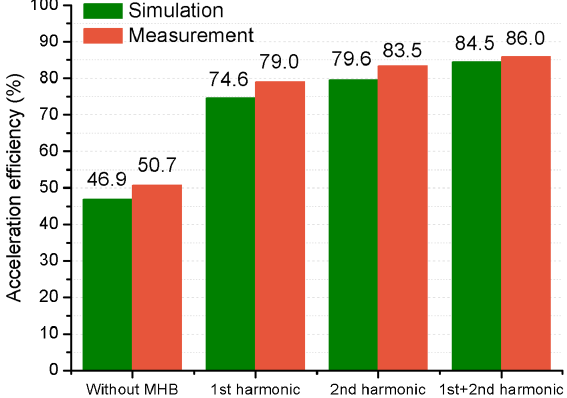
FIG. 25. Measured and simulated acceleration efficiencies of the RFQ for ∼ 100 e μ A N 2 þ beam under different MHB operation conditions.